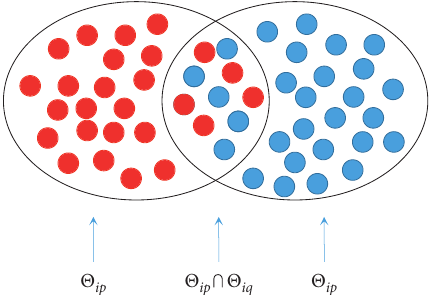
Figure 2: Schematic diagram of confidence ellipse analysis in- cluded in the proposed method, in which a two-dimensional confidence ellipse example is given to deliver the strategy. Here, the two ellipses represent two classes of samples, and the data points with two different colors denote samples corresponding to different classes. The overlapping and nonoverlapping areas of ellipses in- clude the common and noncommon characteristics of the two types of